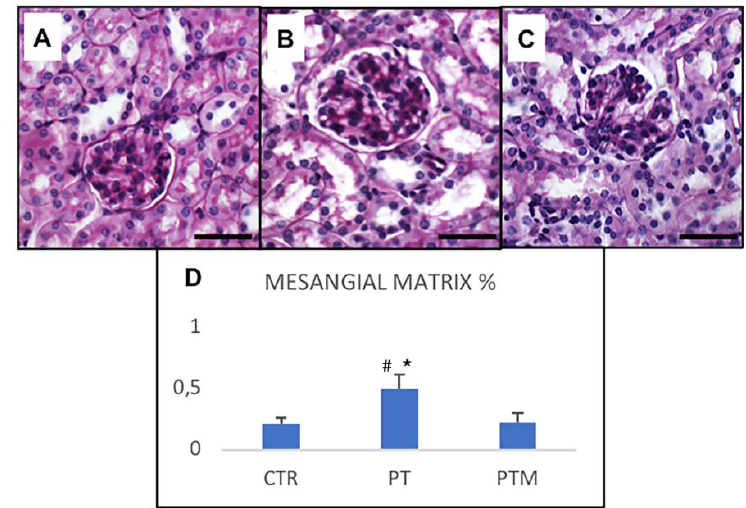
Figure 1. Intraglomerular mesangial matrix and proximal tubules brush border. Photomicrographs showing glomeruli, proximal and distal tubules PAS staining of control mice ( A ), pristane-LN mice ( B ), pristane-LN mice treated with melatonin ( C ). Bar equals 20 μm. The graph ( D ) summarizes the morphometrical analysis of intraglomerular mesangial matrix PAS-positive staining. *# indicate respectively statistically significant differences vs control and pristane-LN mice treated with melatonin: p < 0.05. CTR: control mice PT: pristane-LN mice PTM: pristane-LN mice treated with melatonin.